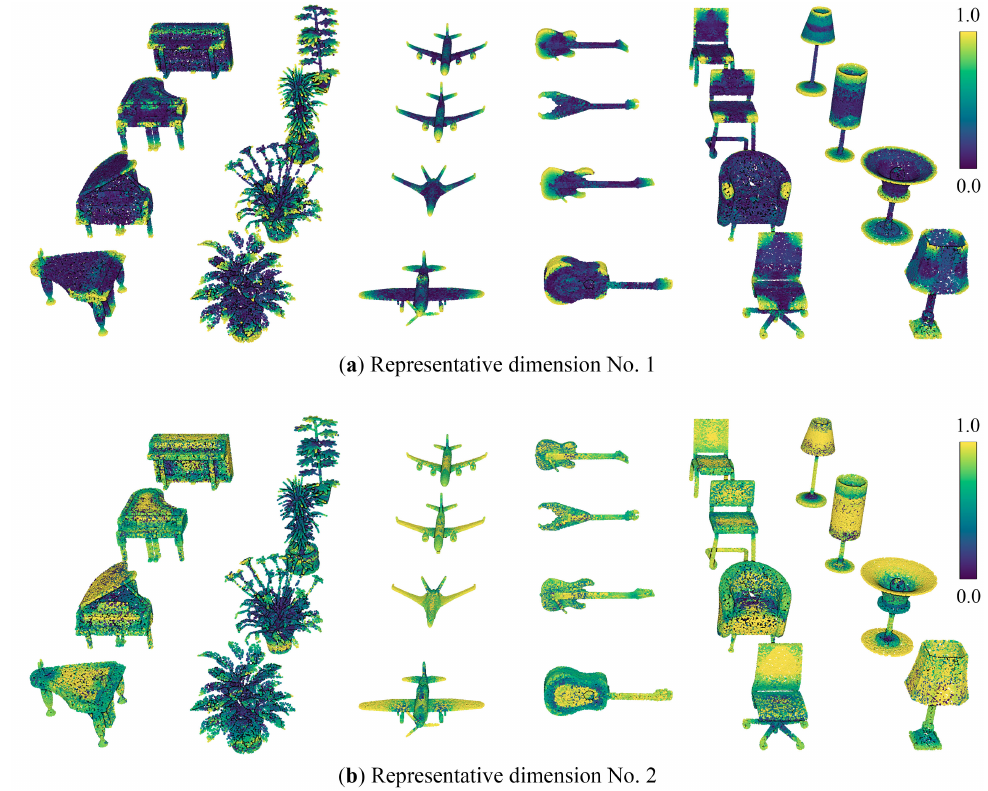
Figure 8. Visualization of two (manually chosen) dimensions of the implicit features for six categories of point clouds from the ModelNet dataset [23].